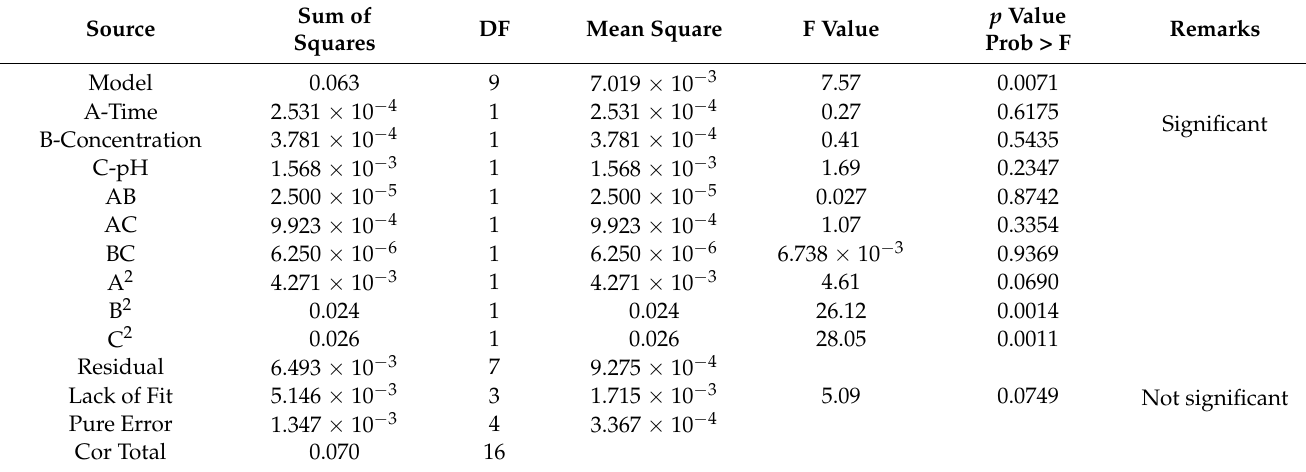
Table 2. The ANOVA for response surface quadratic model to extraction of chlorogenic acid.